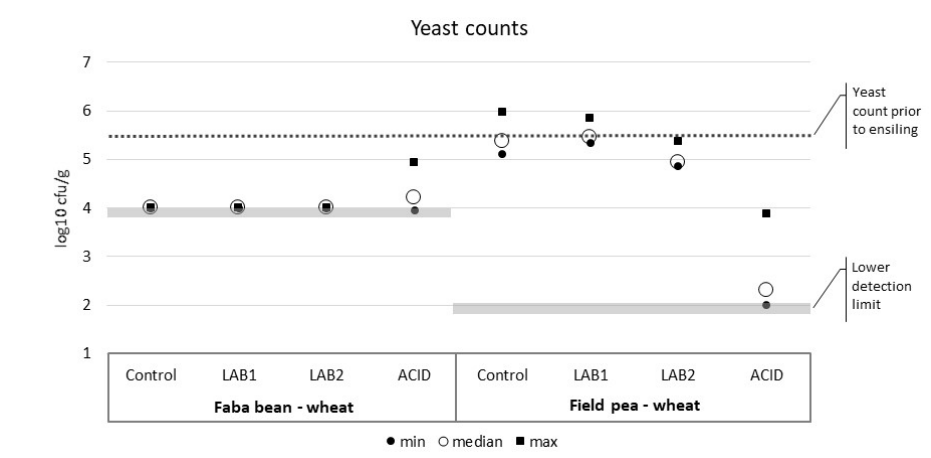
Fig. 1. Yeast counts of the whole crop silages. Different lower detection limit was used for different silage types. Control = without additive; LAB1 = lactic acid bacteria strains; LAB2 = lactic acid bacteria strains and enzymes; ACID = formic acid based additive. For additive treatments, see Table 1.